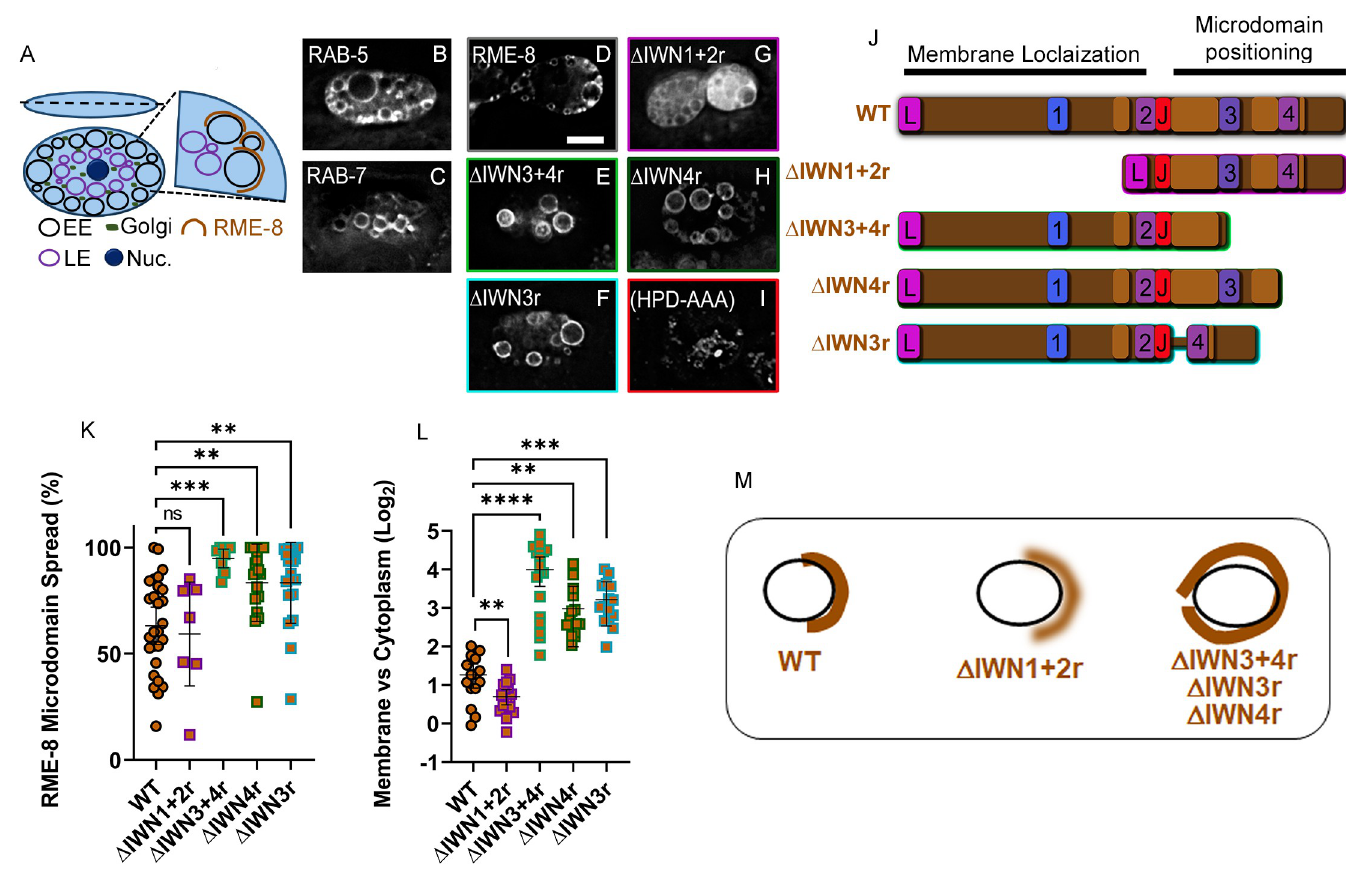
Fig 2. The RME-8 N-terminus controls membrane association, while the C-terminus controls microdomain positioning, and microdomain spread. (A) Early endosomes (EE), Late endosomes (LE), Golgi, and the Nucleus occupy stereotypical positions in the coelomocyte cell. (B-C) Micrograph of tagRFP::RAB-5 (B) and tagRFP::RAB-7 (C) expressed in coelomocytes. (D-I) Micrograph of pCUP-4::GFP::RME-8 wild-type and mutants expressed in wild-type animals. Micrograph of pCUP-4:: GFP::RME-8 N-terminal (G) C-terminal truncations (E, F, and H), and a DNAJ domain mutant where the catalytic triad HPD residues are substitute with alanines (I). (J) To scale illustration of wild-type, N-terminal and C-terminal truncations of RME-8. (K) Ratio of the GFP::RME-8 intensity in the cytoplasm versus on the membrane in the indicated GFP::RME-8 wild-type and truncations indicated in J. Given that a ratio is plotted, we used a Log2 scale. (L) Quantification of the percentage of an endosome covered by the indicated GFP-RME-8 wild-type and truncation mutants. (M) Illustration of the alterations of the RME-8 microdomain that occur in the truncations illustrated in J. All micrographs are deconvolved widefield images (see methods). In K-L each data point is an individual worm, error bars indicate Mean with 95% CI, ANOVA statistical analysis unless ratios are plotted in which case student t-test are used, done in Graphpad Prism with p < 0.01 = �� , p < 0.001 = ��� , p < 0.0001 = ���� . Scale bars are 5 microns in whole coelomocyte images.